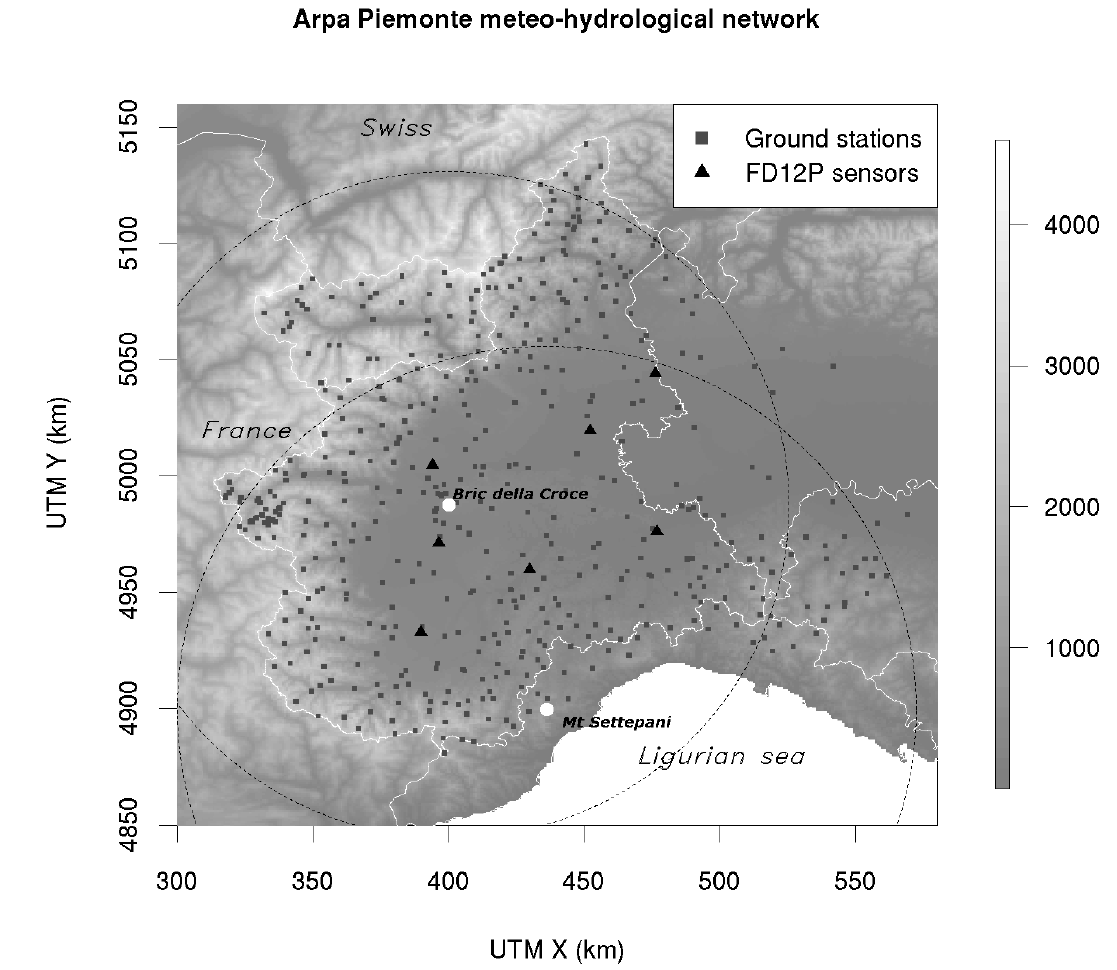
Figure 1. The study area: the Piemonte region. Circle shows radar maximum unambiguous range, points are ground weather station, triangles represent automatic weather sensors. Altitude is expressed in meters above sea